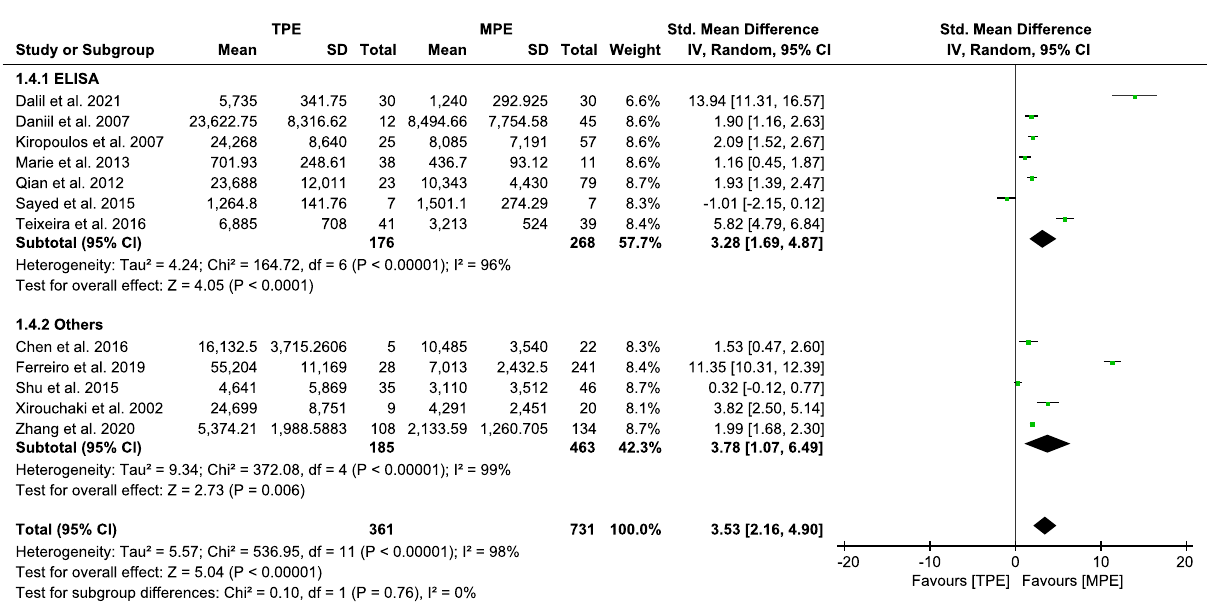
Figure 7. Forest plot of 12 studies comparing IL-6 levels in TPE and MPE subjects. The standardized mean difference (the pleural fluid levels of IL-6 in TPE subjects minus that in MPE subjects) was estimated by meta-